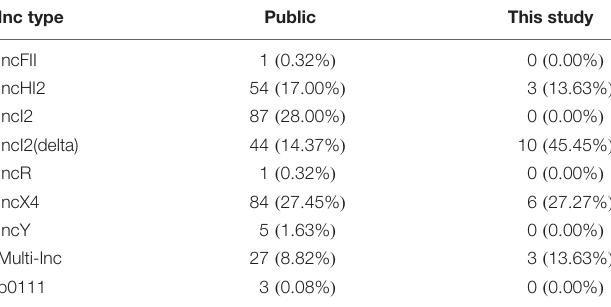
TABLE 2 | Inc types of mcr-1 plasmids identified in public datasets and from this